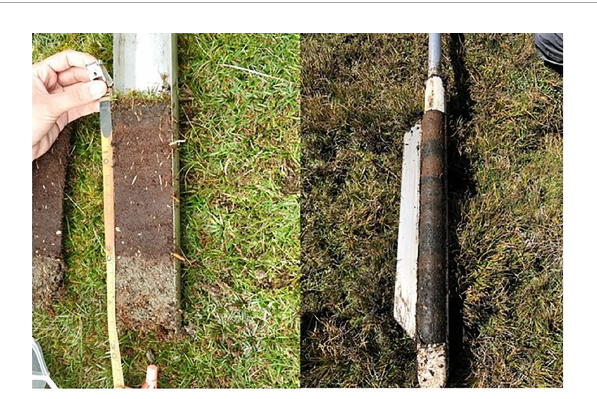
FIGURE 1 Location map Huascara ́ n National Park, Peru showing sampling